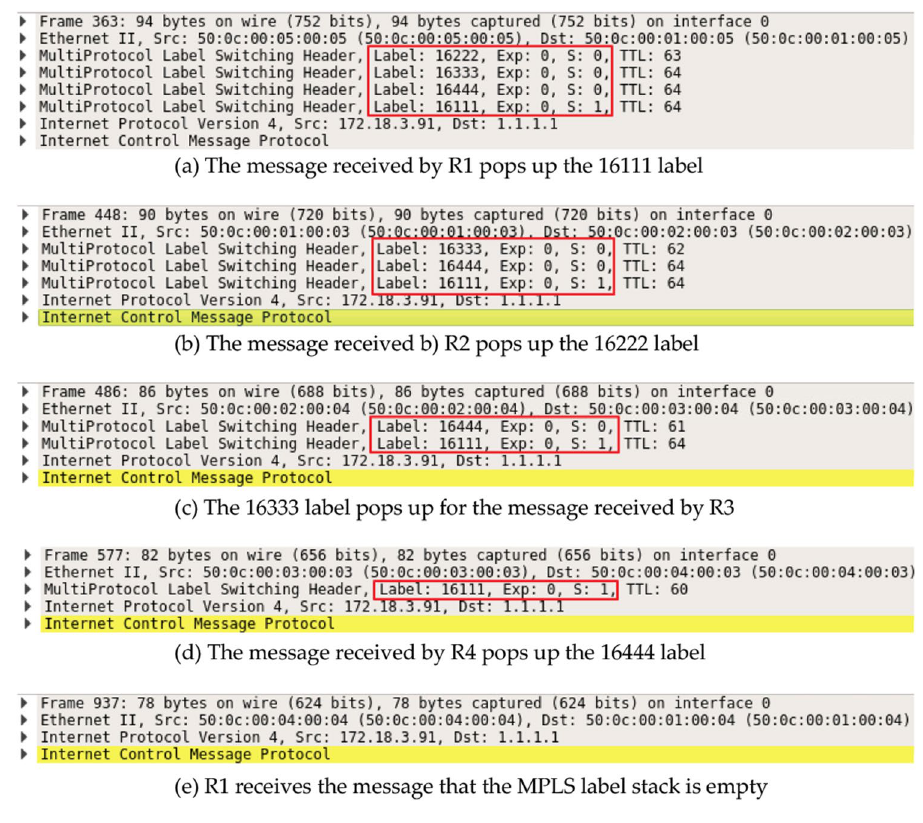
Figure 12. The process of jumping out MPLS labels from R1 to R4.